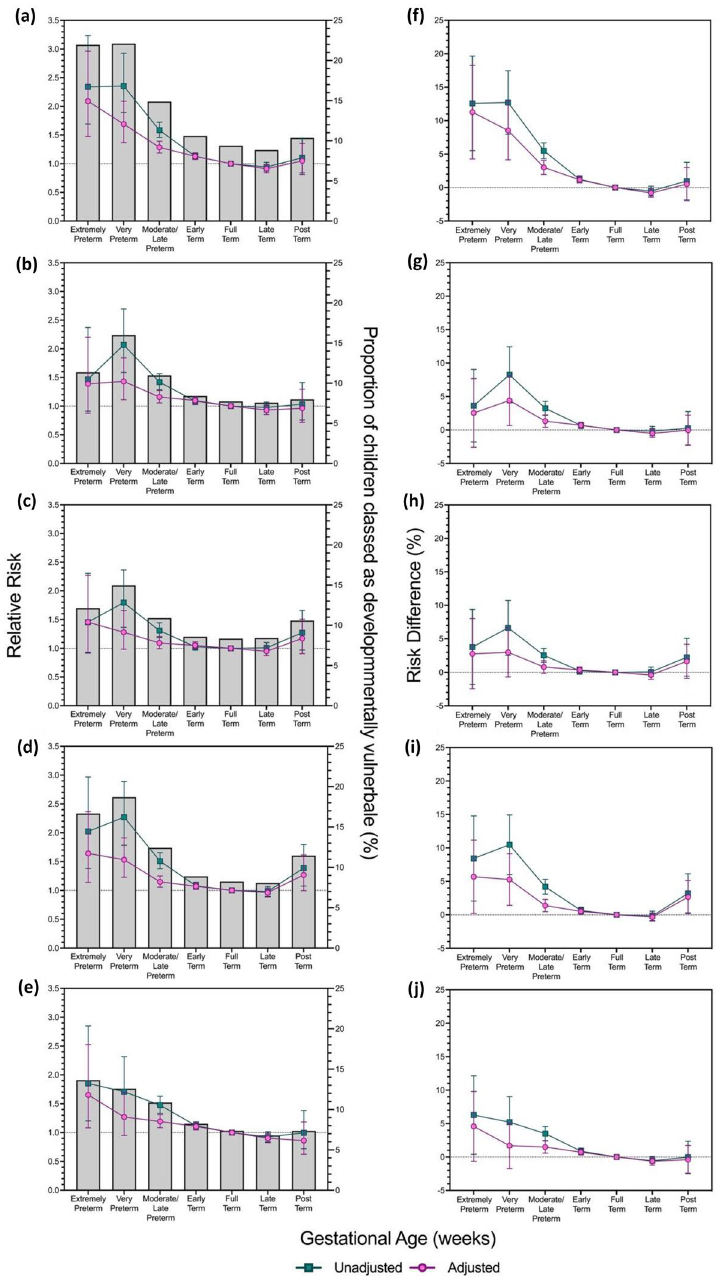
Figure 3. Unadjusted and Adjusted, Relative Risk and Risk Difference, from interaction models for the association between developmental vulnerability for each of the five Australian Early Developmental Census (AEDC) domains; (1) Physical Health and Wellbeing, (2) Social Competence, (3) Emotional Maturity, (4) Language and Cognitive Skills (school-based), and (5) Communication and General Knowledge, and gestational age. The proportion of the study population classified as developmentally vulnerable, overlayed with the relative risk of developmental vulnerability for each outcome by gestational age, relative to children born at full-term (a–e) , and the risk difference of developmental vulnerability (f–j) for each domain. (a,f) Physical Health and Wellbeing, (b,g) Social Competence, (c,h) Emotional Maturity, (d,i) Language and Cognitive Skills (school- based), and (e,j) Communication and General Knowledge. Developmental vulnerability was defined as scores in the bottom decile, based on the 2009 AEDC cut-offs. Adjusted model based on pooled analysis from 20 imputed datasets controlling for; maternal age at time of child’s birth, maternal marital status at time of child’s birth, maternal ethnicity, maternal immigration status, maternal occupational status at time of child’s birth, parity, age of the child at the time of AEDC completion, child’s sex, preschool attendance, the child speaks a language other than English at home, child’s reading status, total number of siblings, and Index of Relative Socioeconomic Disadvantage category. All relative risk data is presented with 95% confidence intervals; modified Poisson